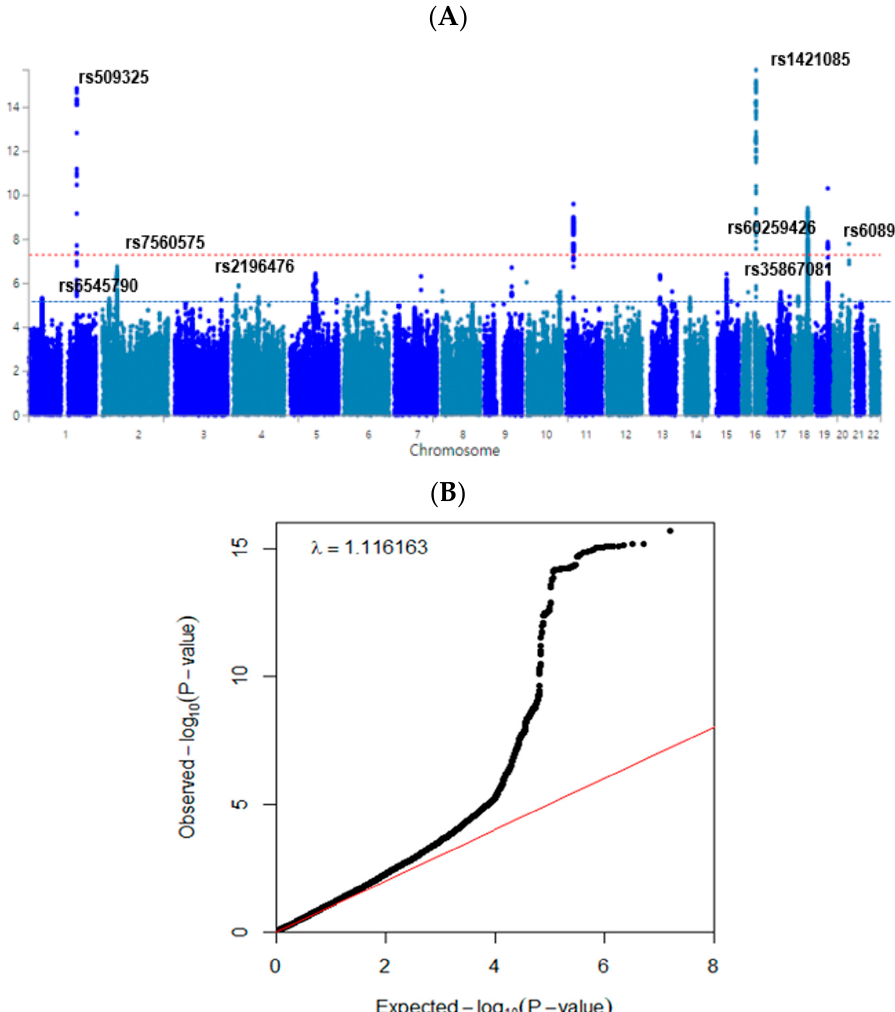
Figure 2. Distribution of genetic variants for high body fat mass risk by genome-wide association study. ( A ) Manhattan plot of the p -value of genetic variants for high body fat risk. Red-dot and blue-dot lines indicate the p -value of 5 × 10 − 8 and 5 × 10 − 5 . ( B ) Q–Q plot of observed and expected p -values for body fat risk. Red and black lines represent theoretical and actual distributions, respectively.